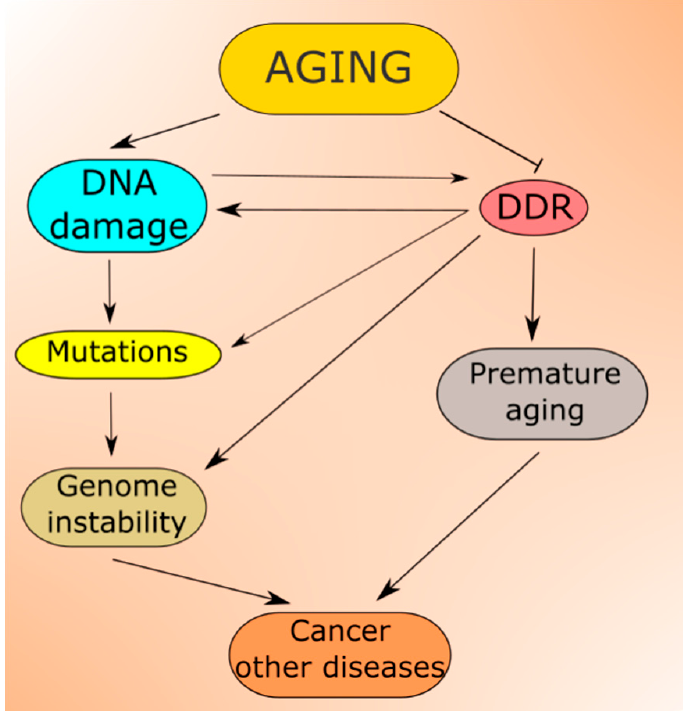
Figure 3. Aging is associated with increased levels of DNA damage, which can be changed into mutations contributing to increased genomic instability, a prerequisite in cancer and many other serious diseases. In normal conditions, DNA damage induces DNA damage response (DDR), which activates cellular pathways to repair the damage, tolerate it or induce programmed cell death. However, aging also affects these pathways lowering the efficacy and accuracy of DDR, increasing the extent of non ‐ repaired and/or misrepaired DNA damage. In fact, faulty DDR may accelerate aging leading to premature aging and progeria syndromes.